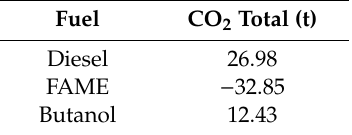
Table 10. Carbon dioxide emissions for a given fuel over the vehicle’s life